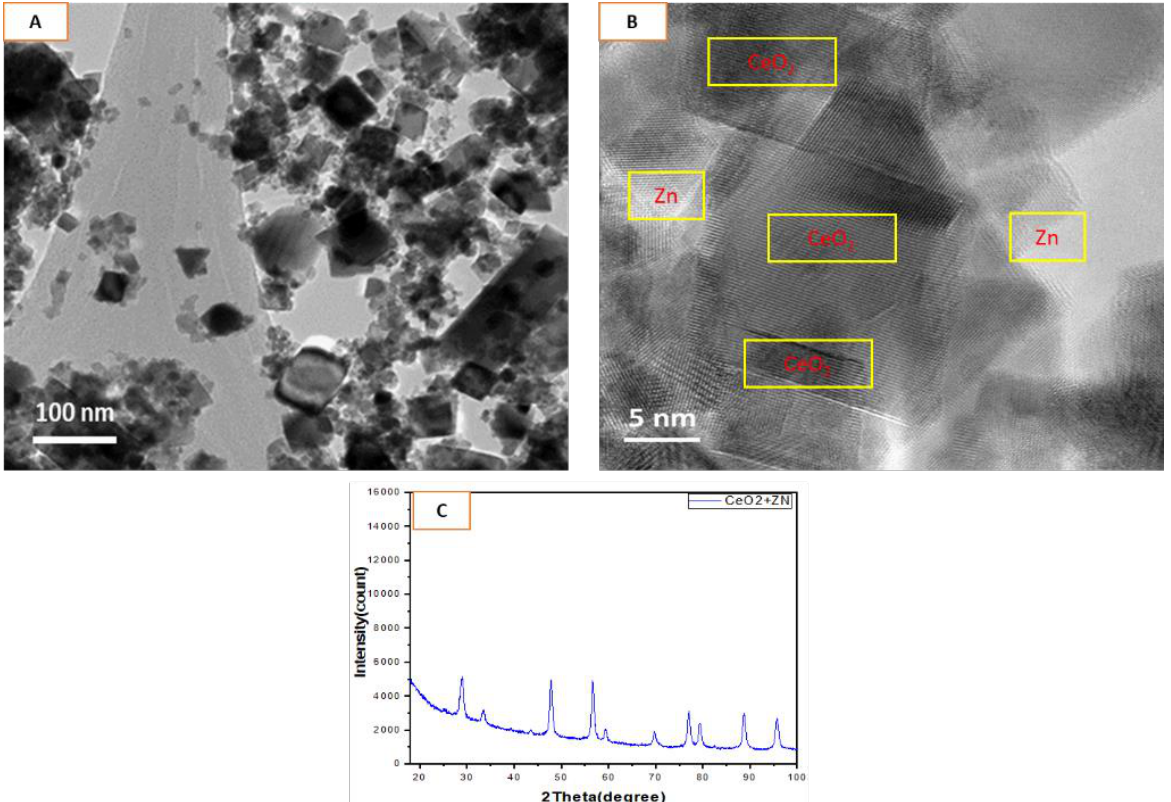
Figure 1. Size, shape and crystallinity characterization of CeO 2 -Zn nanocomposite. ( A ) TEM image captured at 50 nm of resolution and ( B ) captured at 5 nm of resolution (i.e., High-res image). Lighter areas represent Zn whereas relatively darker and larger areas represent CeO 2 NP in high-res image ( B ). XRD of nanocomposite is given in ( C